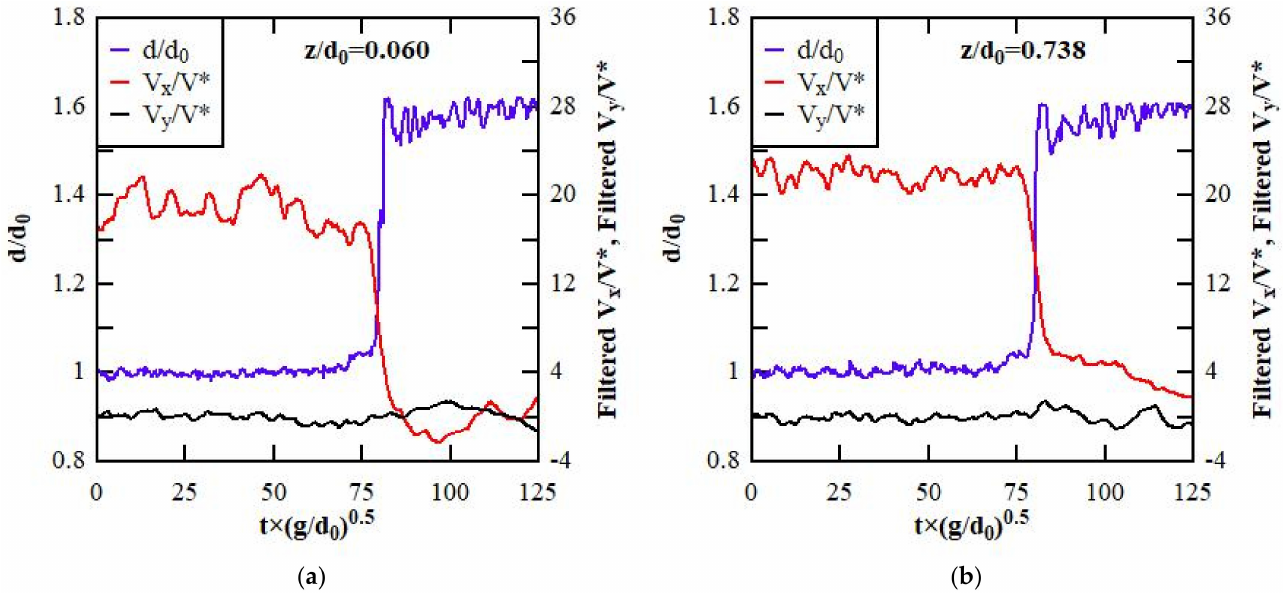
Figure 5. Breaking surge, Run 60-6. Dimensionless instantaneous water depth d/d 0 and velocity components V x / V * and V y / V * ( a ) at z/d 0 = 0.060 (left); ( b ) at z/d 0 = 0.738 (redrawn from